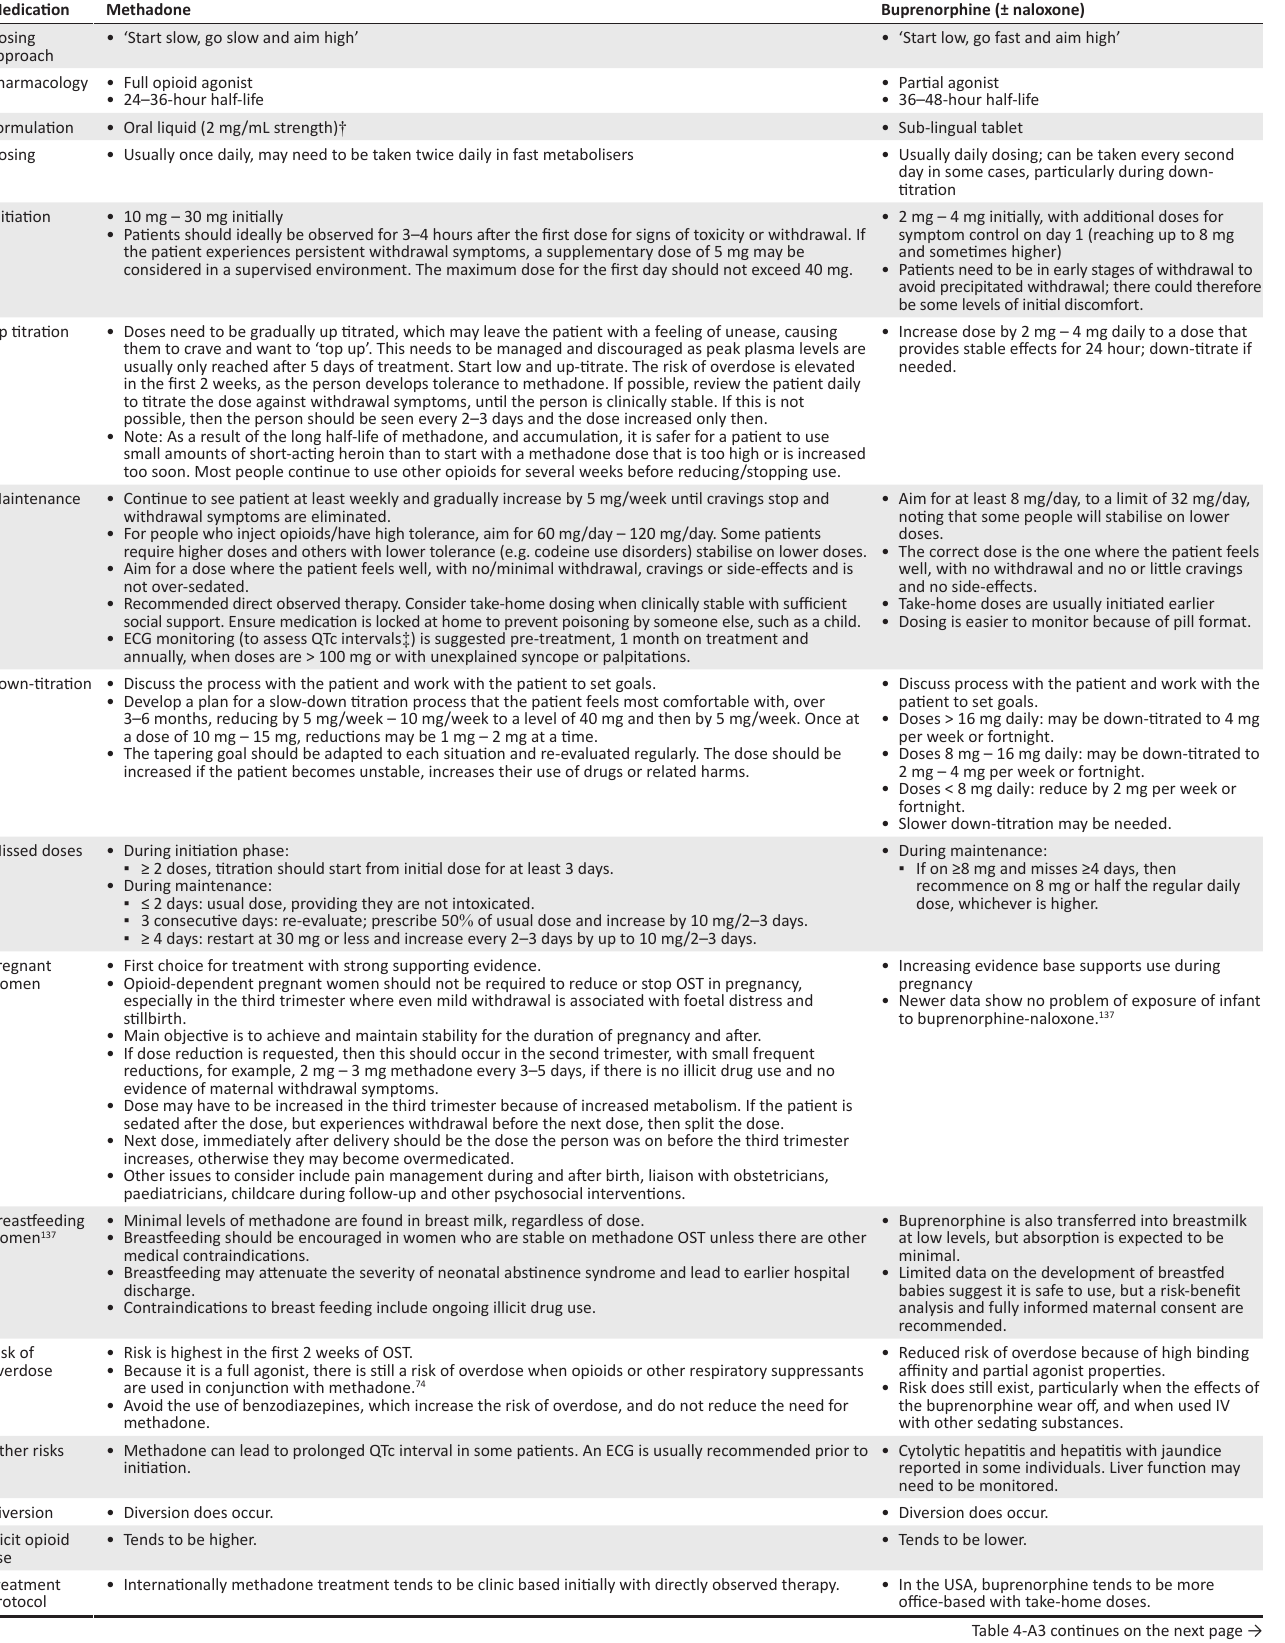
TABLE 4-A3: Comparison between methadone and buprenorphine (± naloxone) and clinical considerations. 74 , 81 Medication Methadone Buprenorphine (± naloxone) Dosing